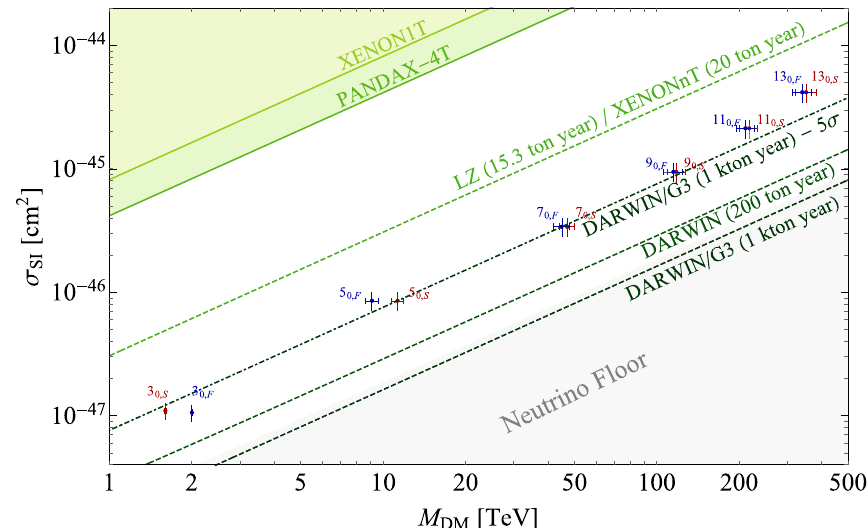
Fig. 7 Expected SI cross-sections for different millicharged complex WIMPs with (cid:18) (cid:3) 10 − 10 . The blue dots correspond to Dirac WIMPs and the red dots to complex scalar WIMPs. The vertical error bands correspond to the propagation of LQCD uncertainties on the elastic cross-section (Eq. 18), while the horizontal error band comes from the